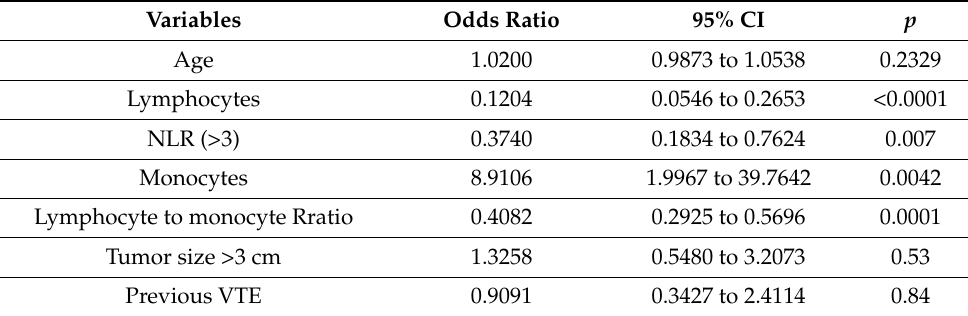
Table 2. Results from univariate logistic regression.